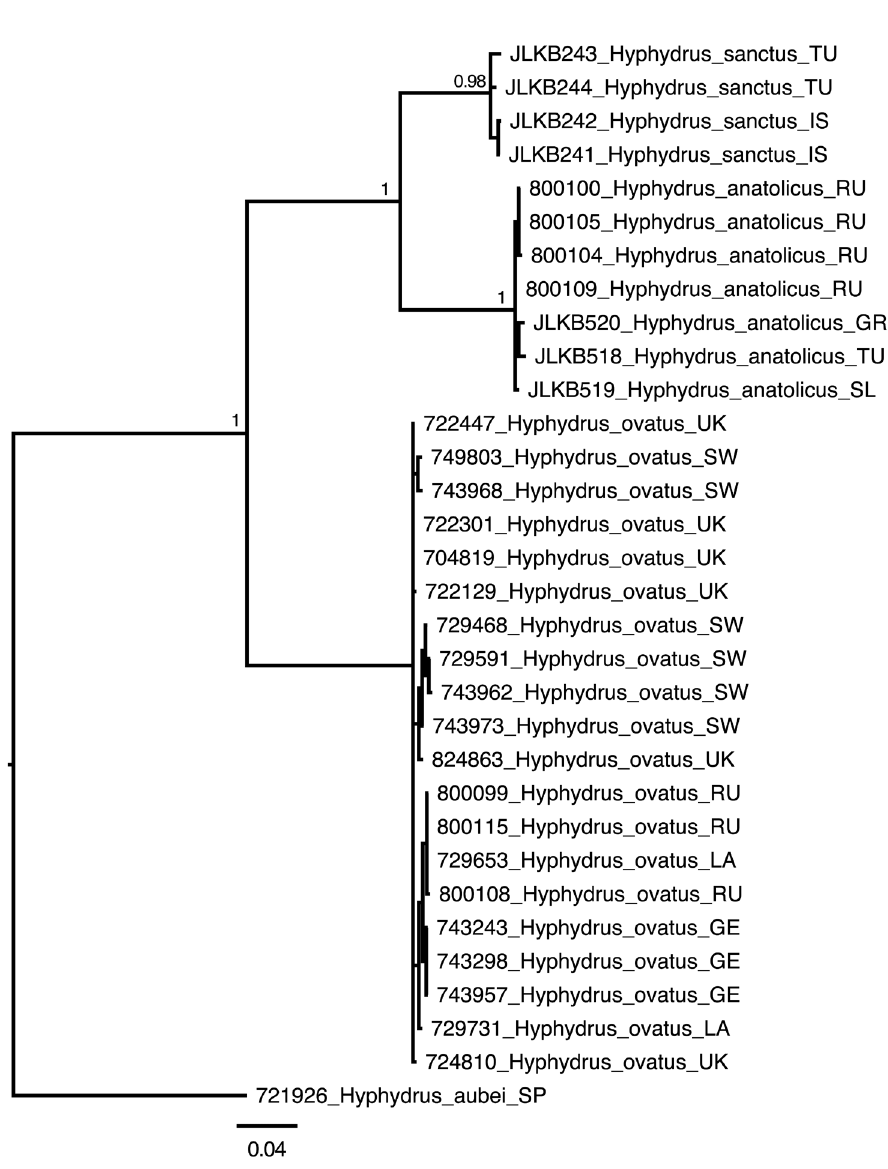
Figure 1. Majority-rule consensus tree from the non-clock Bayesian analysis. Posterior probability clade support values >0.9 shown. Country abbreviations: SW=Sweden, GE=Germany, UK=United Kingdom, La=Latvia, RU=Russia, TU=Turkey, IS=Israel, GR=Greece, SL=Slovakia. Rooted (midpoint) with Hy- phydrus aubei